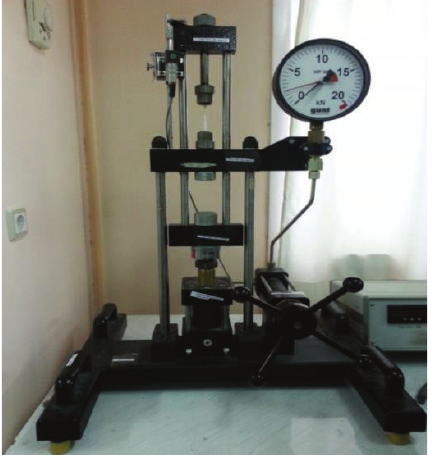
Figure 2: Universal material testing apparatus.